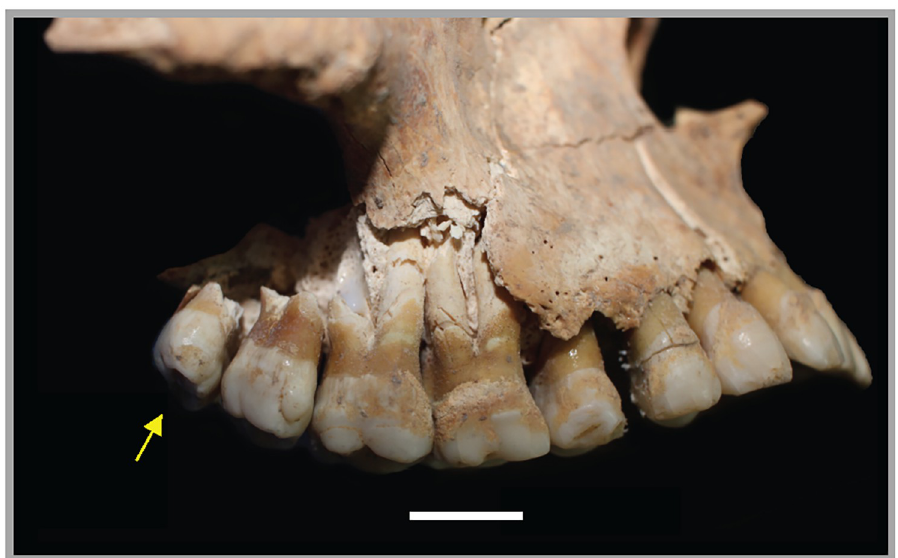
Fig 3. Fourth molar of Individual 1. Image shown in right lateral view. Scale bar is 1